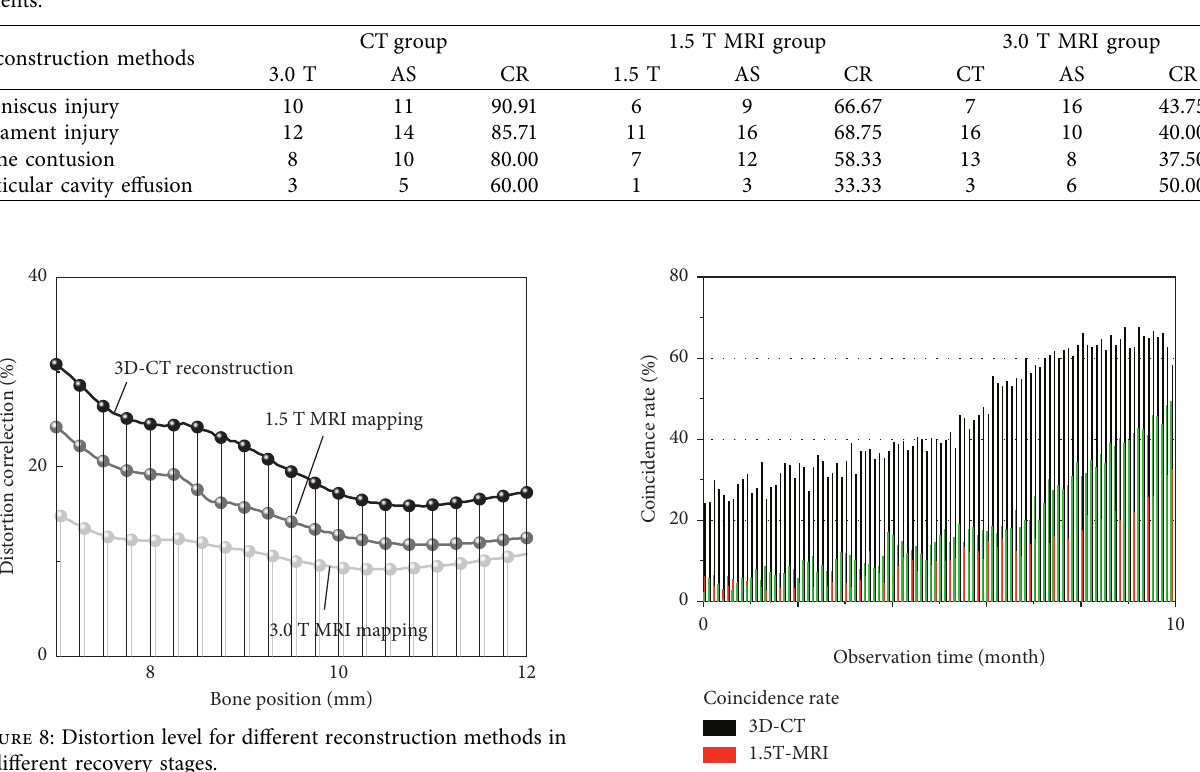
Table 4: Comparison of assessment results of different imaging methods on the exercise rehabilitation therapies of the three groups of patients.